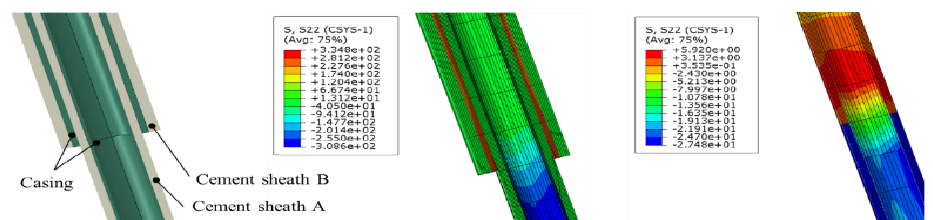
Fig. 7. Cement sheath failure analysis: (a) casing-cement sheath-formation (CCF) assembly (b) stress cloud diagram of CCF (c) stress cloud diagram of cement sheath A..